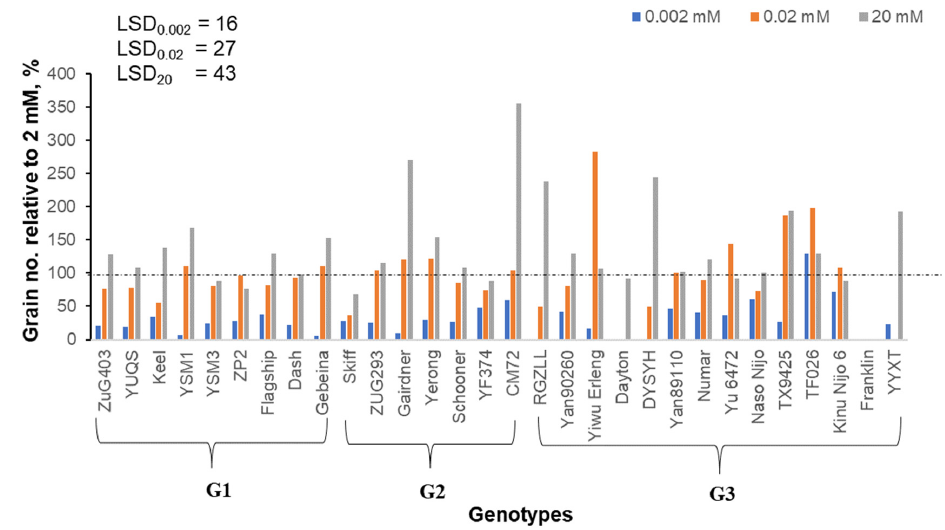
Figure 5. Relative grain number of 30 barley genotypes grown at different K levels (0.002 mM, 0.02 mM and 20 mM) as compared to optimal 2 mM treatment. Genotypes were divided into three groups G1, G2 and G3 (see Figure 1 for details) produced by cluster analysis. Data are means ± SE ( n = 6). LSD are based on significance at p < 0.05 level.